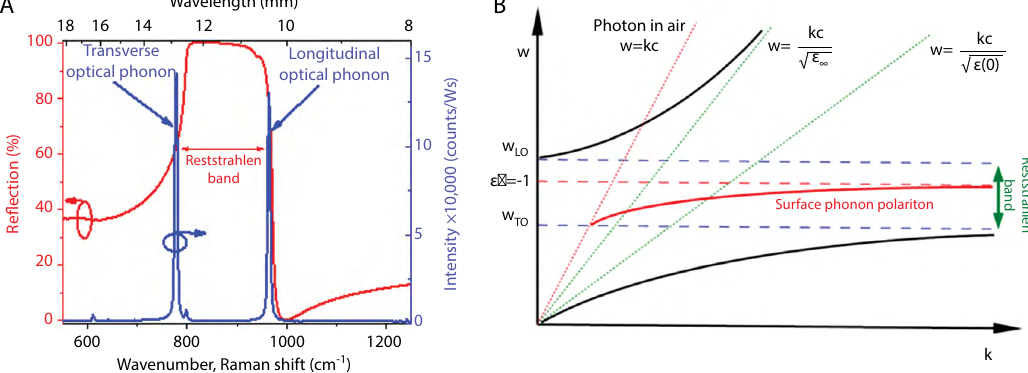
Figure 2 (A) FTIR Reflection (red trace) and Raman (blue trace) spectra collected from a semi-insulating 4H-silicon carbide wafer. (B) Phonon polariton dispersion curve for 4H-SiC for bulk (black lines) and surface (red line) phonon polaritons. The dashed horizontal lines correspond to the frequency locations of the LO and TO phonon frequencies. The dispersion of photons in air (red, dashed diagonal line) and in the high and low frequency limit of SiC (dashed green diagonal lines) are provided for